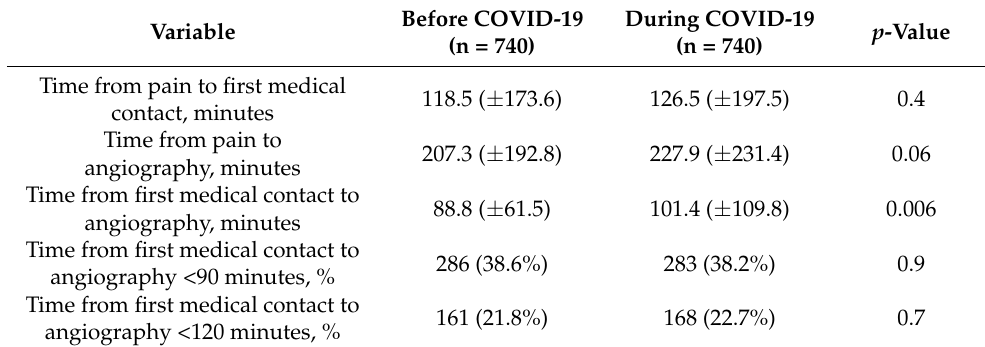
Table 4. Treatment delays after propensity score matching.